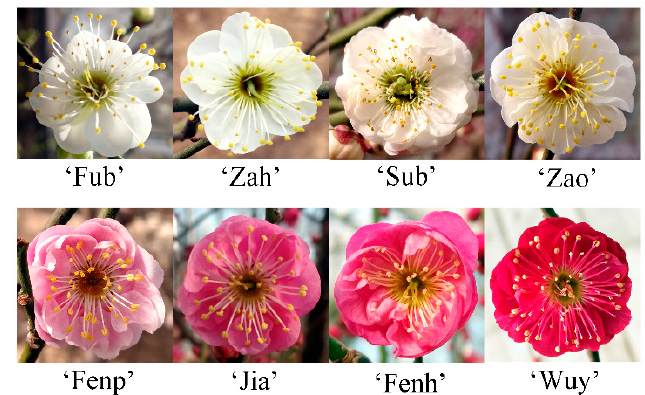
Figure 1. The flowers of eight intraspecific cultivars with different colours. Table 1. Summary of compounds identified in the eight P. mume cultivars.